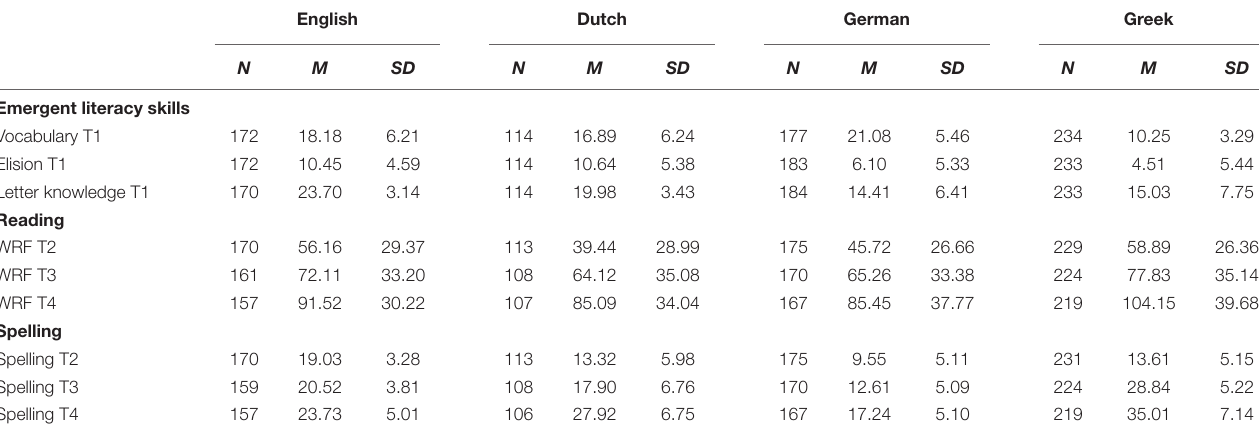
TABLE 3 | Descriptive statistics for child measures at beginning of grade 1, beginning of grade 2, and end of grade 2 within each